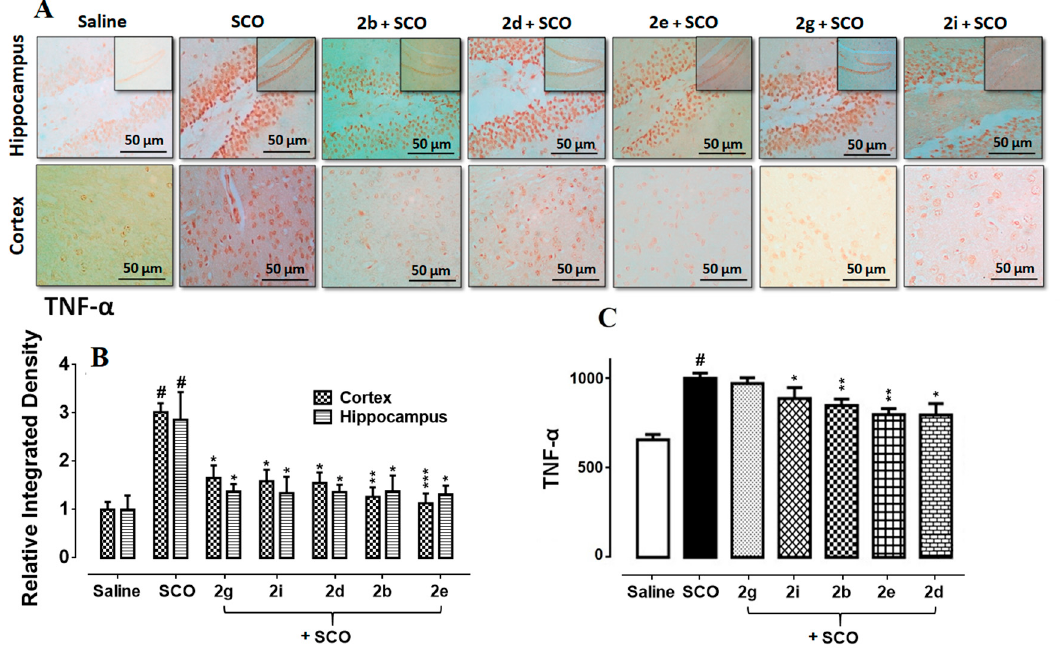
Figure 7. ( A , B ) Immunohistochemistry results for TNF- α in the cortex and hippocampus (dentate gyrus, dg). Bar 50 µ m, magnification 40 × ( n = 5). Histograms show a comparatively higher expression of TNF- α in the scopolamine group. ***, ** and * show p < 0.001, p < 0.01 and p < 0.05, respectively, and illustrate significant variation relative to scopolamine, while ### p < 0.001 shows significant variation relative to saline control group. Results are expressed as mean ± SEM. ( C ) The protein expression of TNF- α quantified through ELISA. The data is presented as mean ± SEM. # p < 0.05 relative to saline control group, while * p < 0.05 and ** p < 0.01 relative to scopolamine ( n = 5).